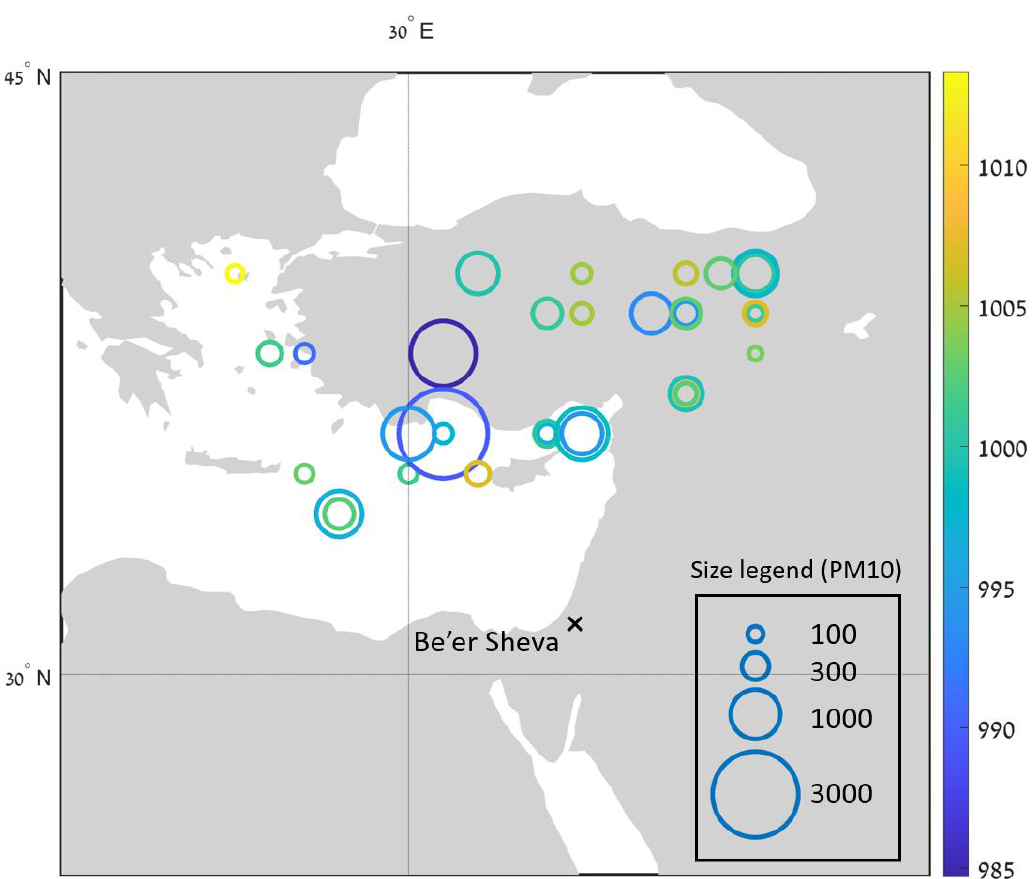
Figure 5. Locations of the cyclone centers between 20–40 ◦ E, 20–40 ◦ N at the timing of minimum central pressure (color) and daily PM 10 in Be’er Sheva (circle size). Only includes days that fall within the back trajectory cluster associated with the highest PM 10 values.